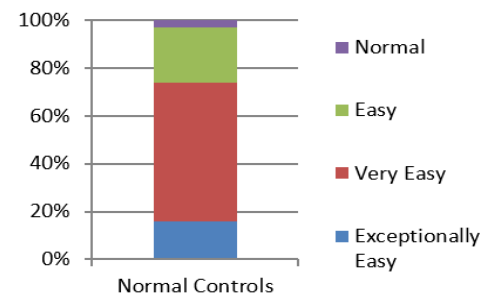
Figure 8. Perceived Difficulty: Benchmark